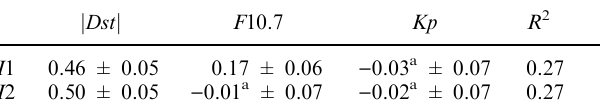
Table 3. Partial correlation coe(cid:129)cients calculated for whole set of data j Dst j